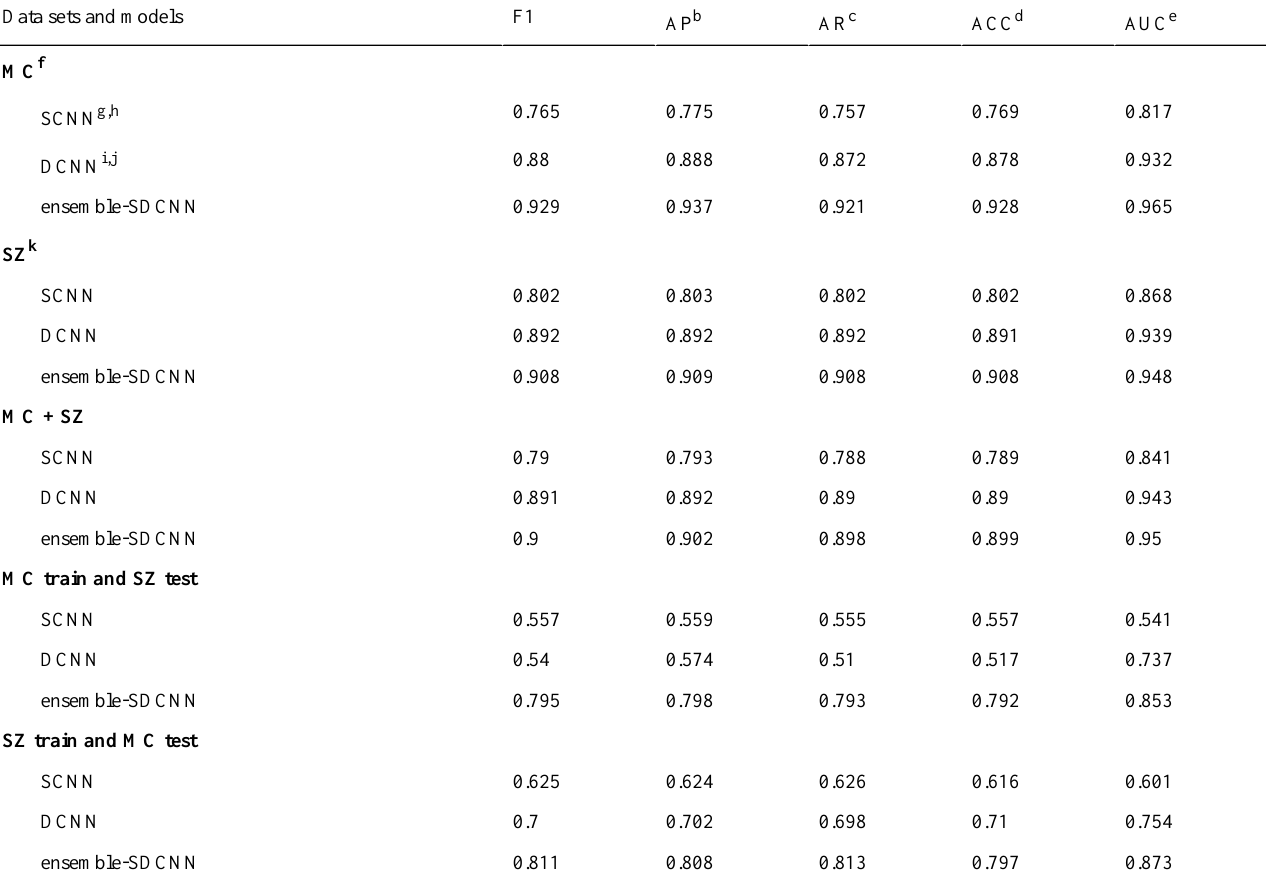
Table 3. Classification performance of our proposed ensemble-SDCNN a model including the submodels as an ablation